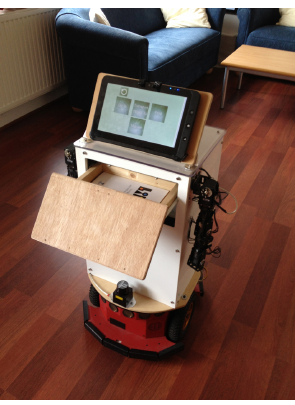
Figure 4: The Replacement Sunflower Robot (SF3) extends its tray and offers to carry an object for the user. Table 1: Differences between the